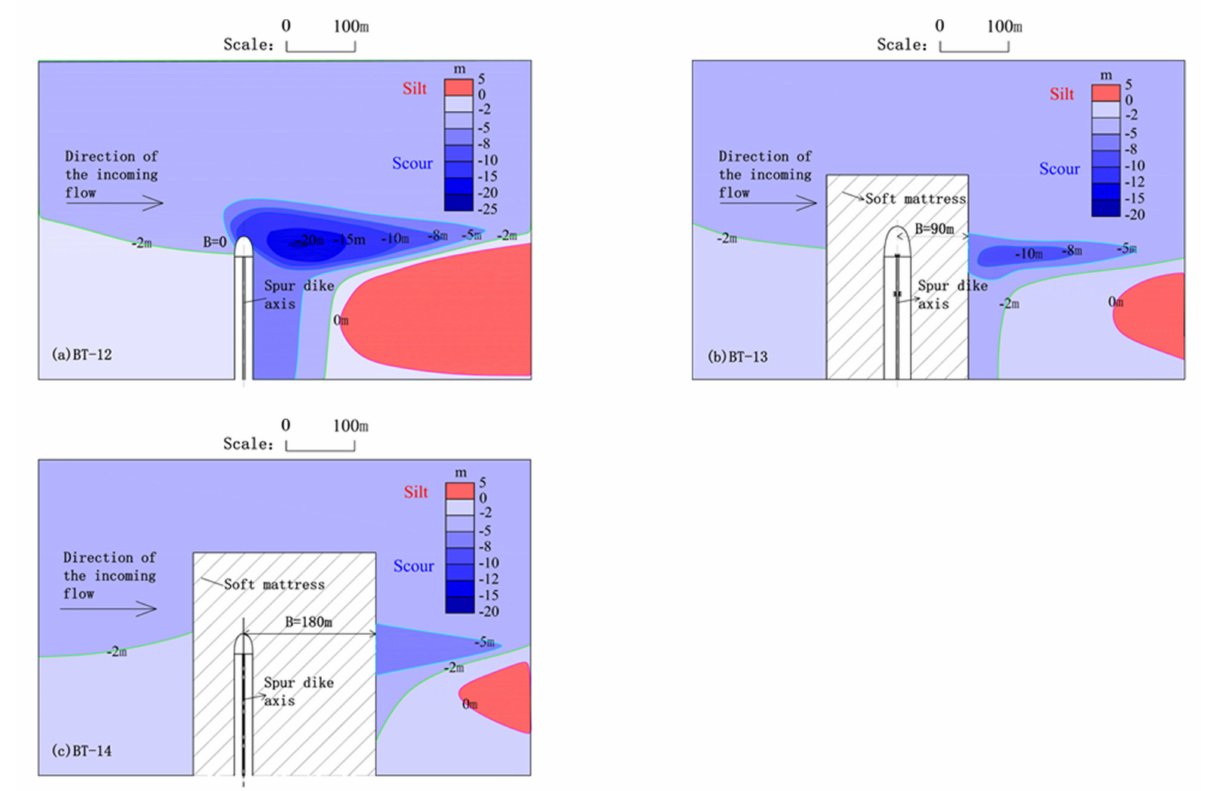
Figure 6. Relationship between the form of the local scouring hole and width of the remaining soft mattress of bottom protection: ( a ) when the B is equal to 0; ( b ) when the B is equal to 90 m; ( c ) when the B is equal to 180